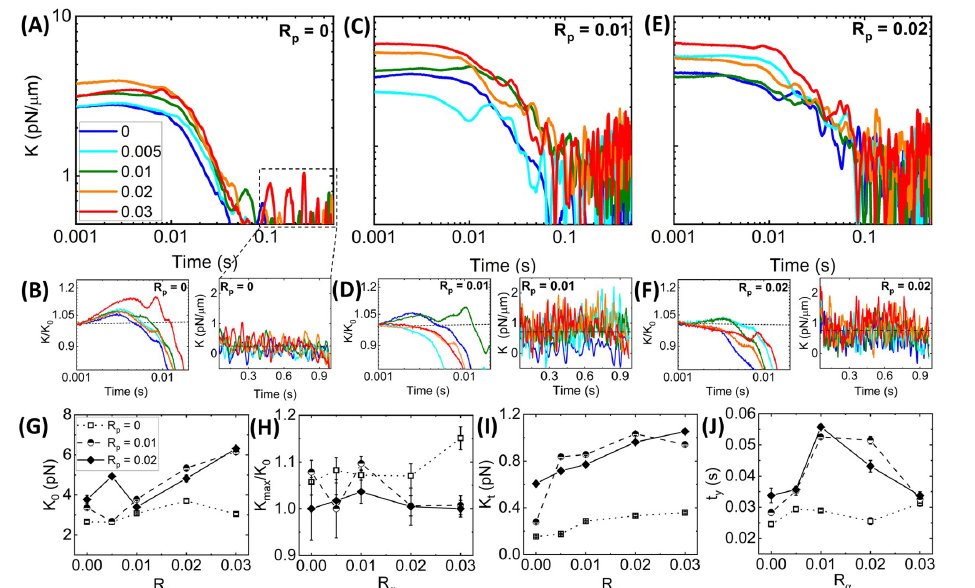
Figure 4. Stabilization suppresses the stress-stiffening behavior of crosslinked networks while increasing the response stiffness and associated yield times . ( A ) Effective differential modulus K ( t ) = dF ( x , t ) / dx as a function of time during strain t = v / x , computed for each average force curve shown in Figure 3A. The color-coded curves are for R α values indicated in the legend. ( B ) K ( t ) data shown in ( A ) normalized by the corresponding initial value K 0 ( left ) with the horizontal dashed line at K ( t ) / K 0 = 1 guiding the eye to show stress stiffening ( K ( t ) / K 0 > 1) or softening ( K ( t ) / K 0 < 1). Zoom-ins of K ( t ) near the end of the strain ( right ) where K ( t ) is approximately constant, with the dashed horizontal line denoting the average. ( C – F ) Metrics plotted in ( A , B ) for networks with R p = 0.01 ( C , D ) and R p = 0.02 ( E , F ). ( G – J ) Quantities computed from the data shown in ( A – F ) as functions of R α for R p = 0 (open squares, dotted connecting lines), R p = 0.01 (half-filled circles, dashed connecting lines), and R p = 0.02 (solid diamonds, solid connecting lines): ( G ) Initial differential modulus K 0 ; ( H ) Degree of stress stiffening, quantified as K max / K 0 and equal to 1 for networks which only display softening (i.e., K max = K 0 ); ( I ) Terminal stiffness K t computed by averaging over the K ( t ) data shown in the right-hand panels of ( B , D , F ); ( J ) Yield time t y , defined as the time at which K ( t ) = K 0 / e . Error bars shown in ( G – J ) represent the standard error of values computed from 5 random subsets of the data, as described in Materials and